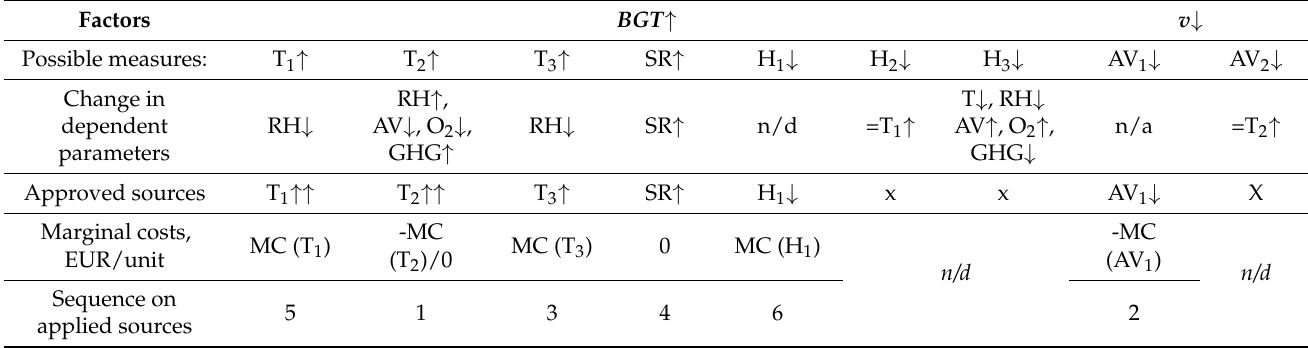
Table 4. Making a sequence on applying sources for microclimate correction.